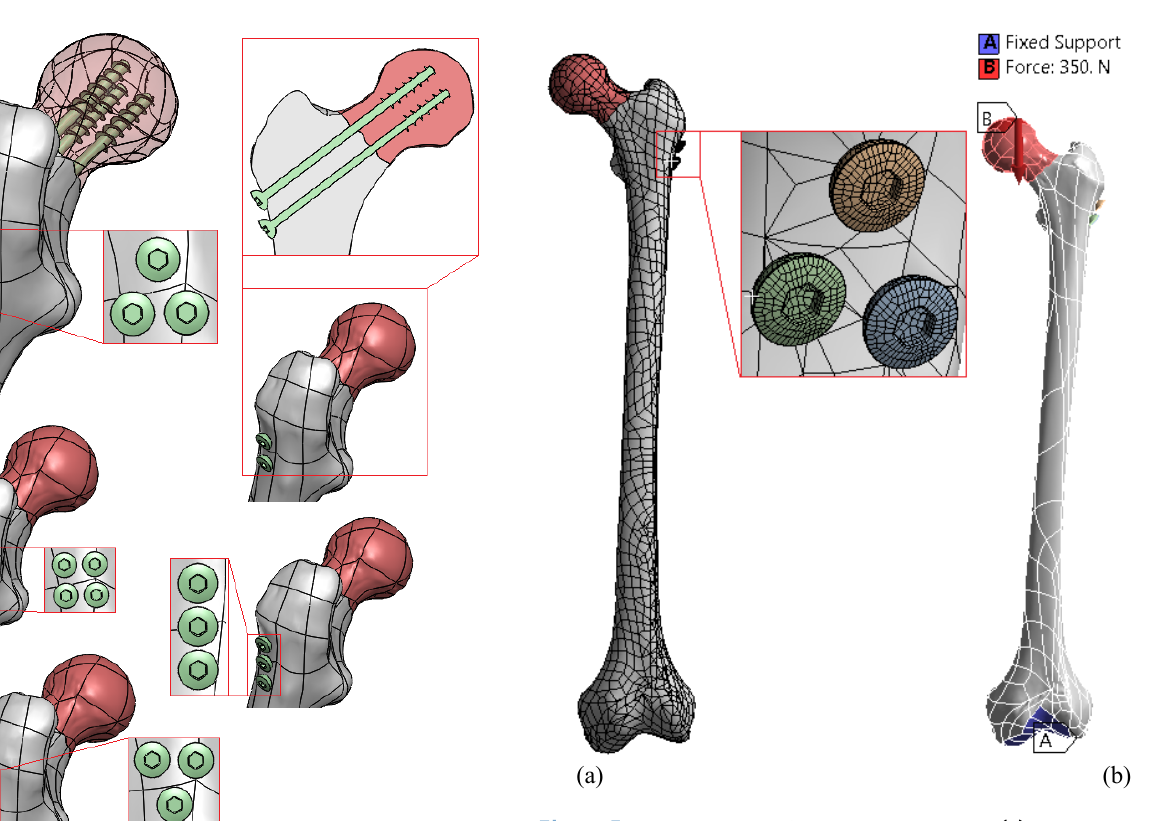
Figure 5. Mesh structure of triangle configuration (a) , loading and fixing (b)